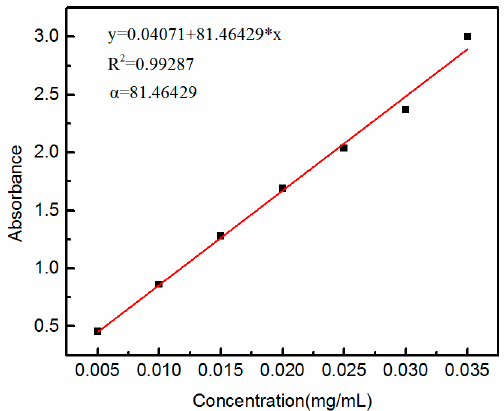
Figure 1. The correlation between graphene oxide (GO) concentrations and its UV absorbance intensity at 227 nm.